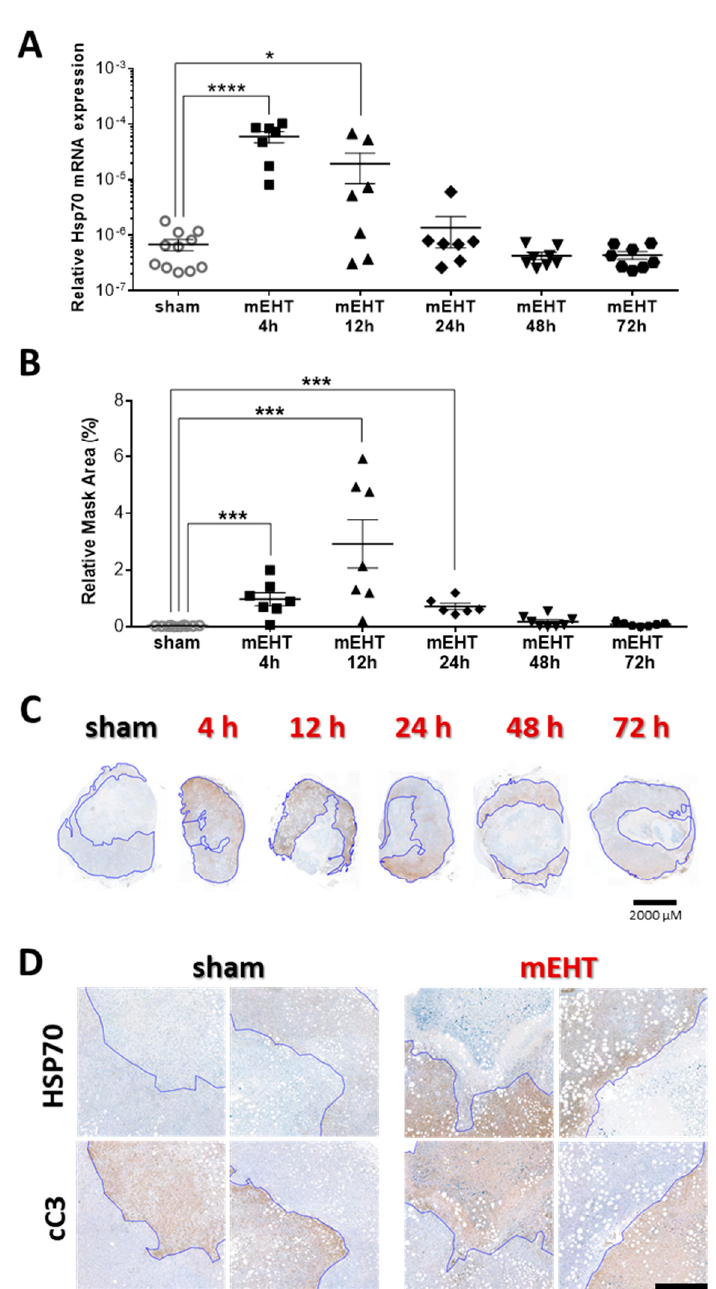
Figure 8. Time kinetics of Hsp70 expression after three mEHT treatments. ( A ) Hsp70 mRNA expression of the tumors at different time-points after treatment; ( B ) Area-proportional expression of Hsp70 protein at different time points after treatment; ( C ) Representative tumor images from the sham and mEHT groups; ( D ) High-magnification images of cC3 and Hsp70 stainings from sham and mEHT treated tumors. Blue line marks the border between live and damaged tumor area assigned based on the cC3-stainings, (Magnification: 5×); ( A , B ) sham vs. mEHT, unpaired Mann–Whitney test. * p = 0.03, *** p < 0.001, **** p < Mean ± SEM, * p = 0.03, *** p < 0.001, **** p < 0.0001 .